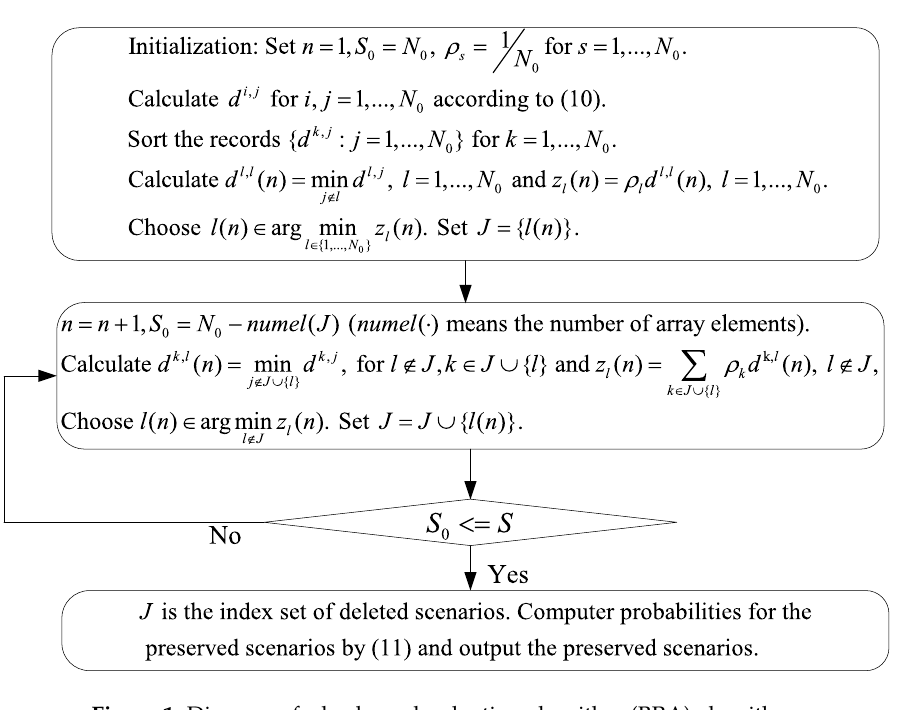
Figure 1. Diagram of a backward reduction algorithm (BRA)